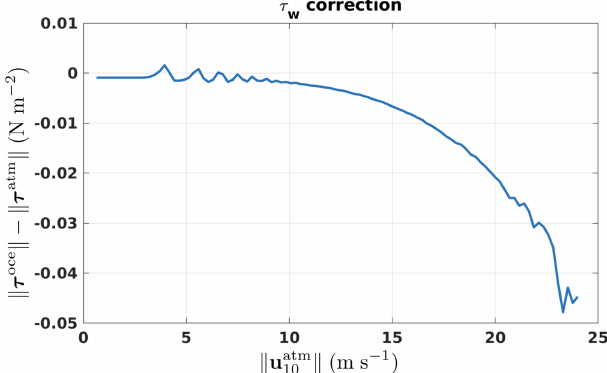
Figure 5. Wind stress difference (cid:107) τ oce (cid:107)−(cid:107) τ atm (cid:107) (N m − 2 ) due to the correction made for growing waves for the WS_CPL experiment as a function of the 10m wind speed.